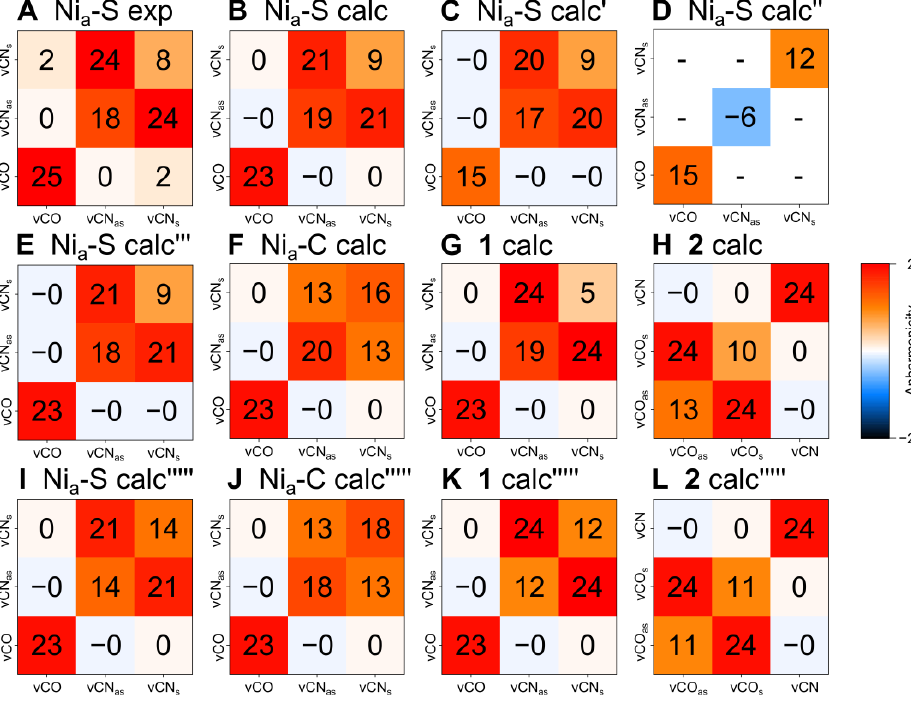
Figure 4. Matrix representation of intramode anharmonicities ∆𝜔 1−2𝑎 and intermode anharmonicities ∆𝜔 𝑎/𝑏 of νCX ligand stretch vibrations. Diagonal entries correspond to ∆𝜔 1−2𝑎 , while off-diagonal entries correspond to ∆𝜔 𝑎/𝑏 . ( A ) Ni a - S state of [NiFe] hydrogenase, experiment. ( B ) Ni a - S state of [NiFe] hydrogenase, calculated. All vibrational degrees of freedom were included in the anharmonic analysis. ( C ) Ni a - S state of [NiFe] hydrogenase, calculated. Only interacting νCO and νCN vibrations were included in the anharmonic analysis ( ∆𝜔 and ∆𝜔 𝑎/𝑏 ′ ). ( D ) Ni a - S state of [NiFe] hydrogenase, calculated. Only non-interacting νCO and νCN vibrations were included in the anharmonic analysis ( ∆𝜔 1−2νCO ′′ ). ( E ) Ni a - S state of [NiFe] hydrogenase, calculated. Only interacting νCO , νCN , νFe–CO/CN , and δFe–CO/CN vibrations were included in the anharmonic analysis ( ∆𝜔 1−2νCO ′′′ and ∆𝜔 𝑎/𝑏 ′′′ ). ( F ) Ni a - C state of [NiFe] hydrogenase, calculated. All vibrational degrees of freedom were included in the anharmonic analysis. ( G ) Model complex 1 , calculated. All vibrational degrees of freedom were included in the anharmonic analysis. ( H ) Model complex 2 , calculated. All vibrational degrees of freedom were included in the anharmonic analysis. ( I ) Ni a - S state of [NiFe] hydrogenase, calculated. All vibrational degrees of freedom were included in the anharmonic analysis, but 2-2 Darling – Dennison (DD) resonances were not considered ( ∆ ω ν CO 1 − 2 and ∆ ω a / b (cid:48)(cid:48)(cid:48)(cid:48)(cid:48) ). ( J ) Ni a − C state of [NiFe] hydrogenase, calculated. All vibrational degrees of freedom were included in the anharmonic analysis, but 2-2 DD resonances were not considered. ( K ) Model complex 1 , calculated. All vibrational degrees of freedom were included in the anharmonic analysis, but 2-2 DD resonances were not considered. ( L ) Model complex 2 , calculated. All vibrational degrees of freedom were included in the anharmonic analysis, but 2-2 DD resonances were not considered. δ —bending vibration; ν —stretching